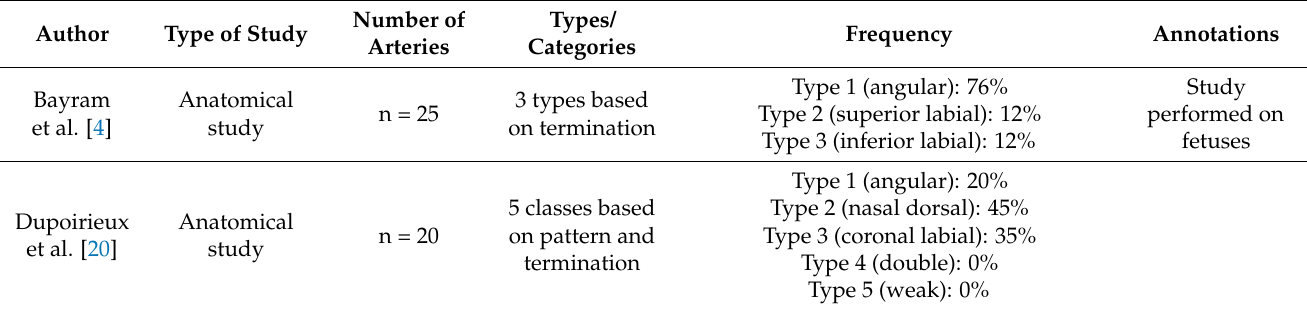
Table 1. Summary of described branching patterns of the facial artery and their frequency (literature